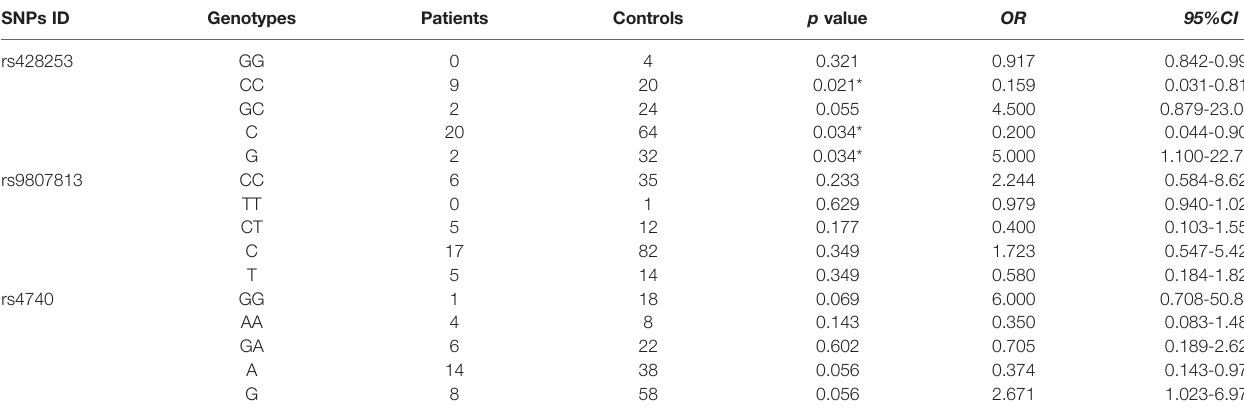
Fisher ’ s Exact Test; OR, odds ratio; CI, con fi dence interval;* there is a signi fi cant difference (*p<.0.05).